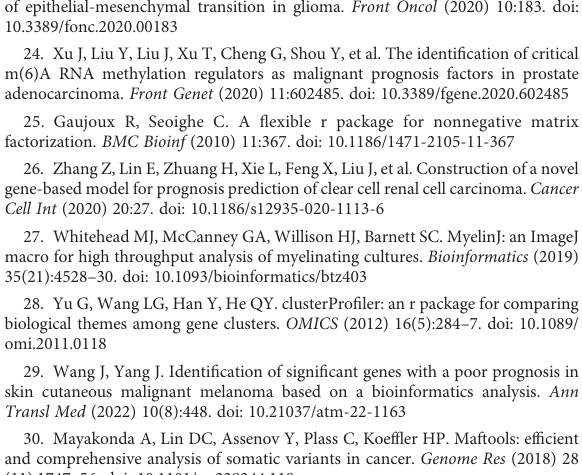
SUPPLEMENTARY FIGURE 1 The KIRC patients with different expression levels of the four AAG-related lncRNAs had different overall survival by Kaplan – Meier curves.